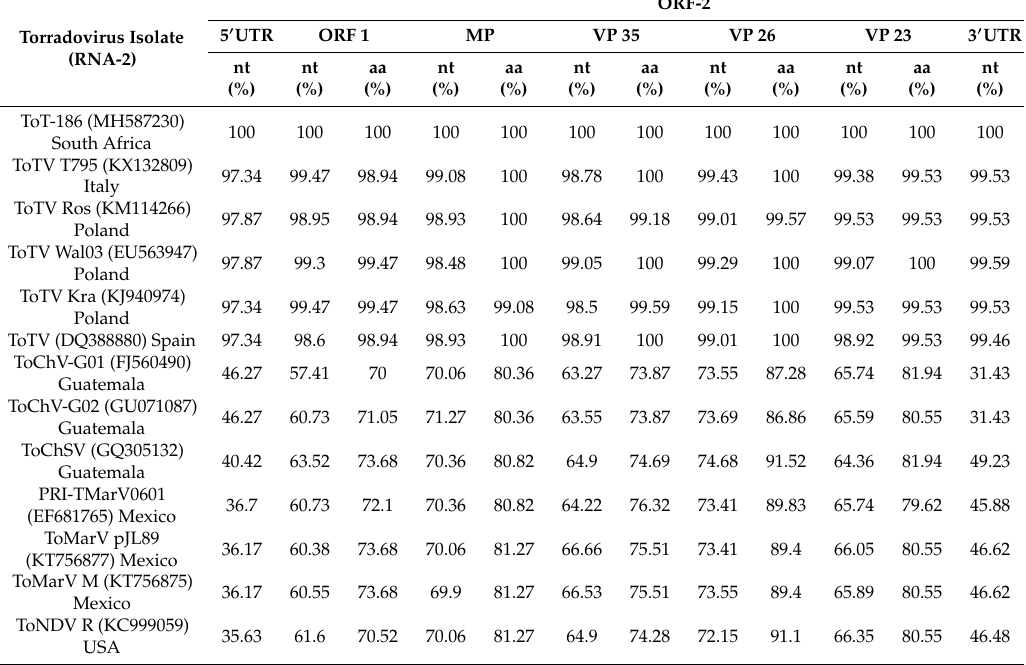
Table 2. A comparison of the nucleotide and amino acid similarities of coding and non-coding regions on the RNA-2 fragment of ToTV from South Africa (ToT-186) with all other fully sequenced tomato-infecting torradovirus species identified throughout the